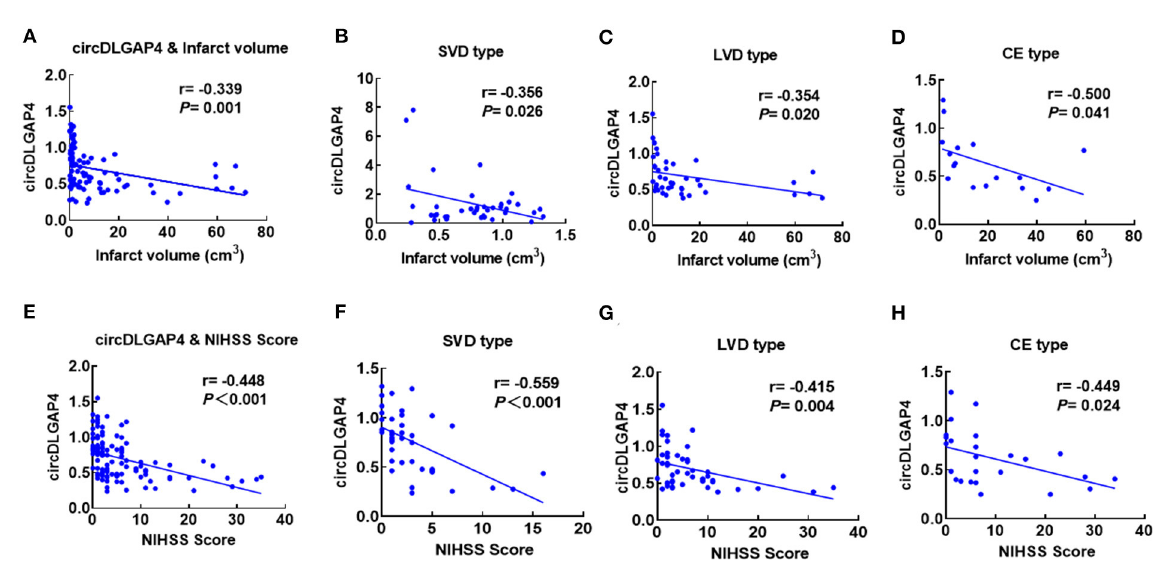
FIGURE2 Correlation between plasma circDLGAP4 levels and stroke severity. (A) Correlation between plasma circDLGAP4 levels and infarct volume. Patients with AIS were recruited for infarct volume measurements. Correlation was estimated by calculating Pearson’s correlation coefficient ( r = − 0.339, p = 0.001). (B–D) Correlations between circDLGAP4 levels in SVD (B) , LVD (C), and CE (D) patients with stroke and infarct volume using Pearson’s correlation coefficient (SVD: r = − 0.356, p = 0.026; LVD: r = − 0.354, p = 0.020; CE: r = − 0.500, p = 0.041). (E) Correlation between plasma circDLGAP4 levels and the NIHSS score. Patients with AIS were recruited for infarct volume measurements. Correlation was estimated by calculating Pearson’s correlation coefficient (r = − 0.448, p <0.001). (F–H) Correlations between circDLGAP4 levels in SVD (F) , LVD (G), and CE (H) patients with stroke and NIHSS scores using Pearson’s correlation coefficient (SVD: r = − 0.559, p < 0.0 01; LVD: r = − 0.415, p = 0.004; CE: r = − 0.449, p = 0.024).